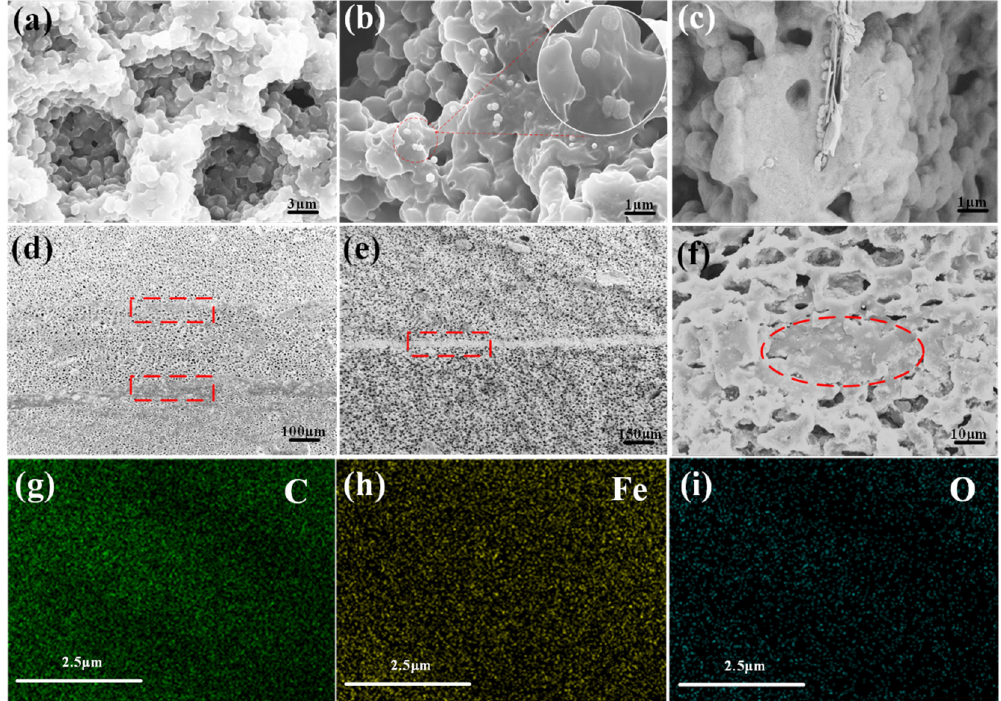
Figure 5. SEM images of cross-sections of samples under different magnifications ( a ) SEM image of Fe 3 O 4 /PU at 5000× magnification; ( b ) SEM image of CNTs@Fe 3 O 4 /PU at 8000× magnification; ( c ) SEM image of CNTs@GN@Fe 3 O 4 /PU at 6000× magnification; ( d ) SEM image of three-layer foam at 50× magnification; ( e ) SEM image of three-layer foam at 100x magni- fication; ( f ) SEM image of three-layer foam at 1000× magnification; ( g,h,i ) element mapping.